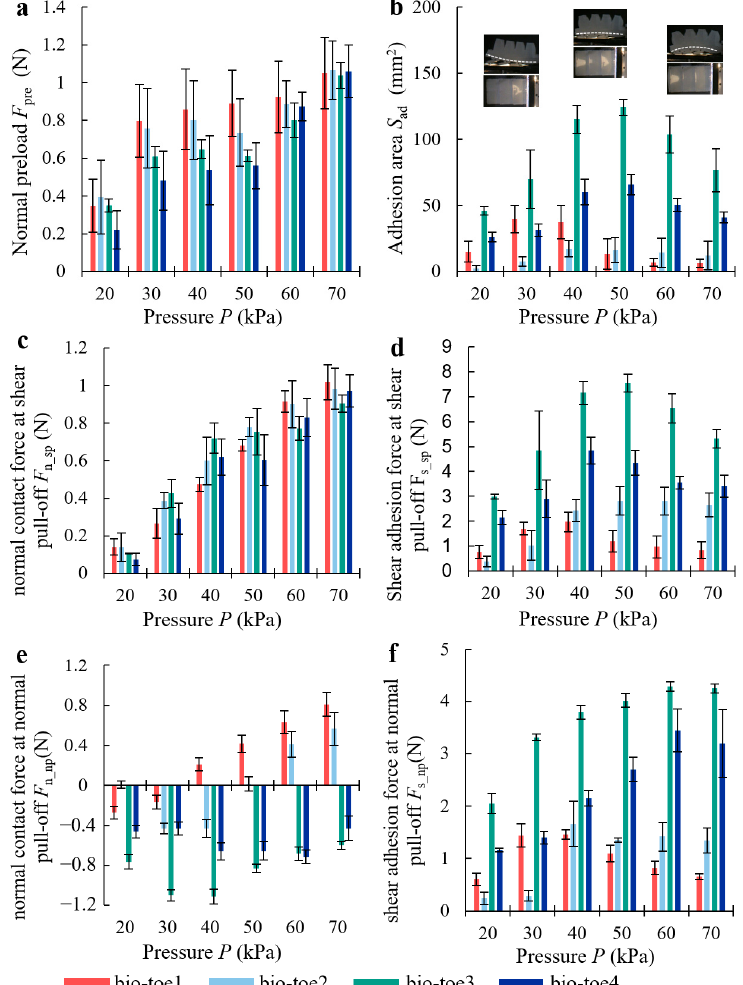
Figure 8. ( a ) Normal preload F pre and ( b ) adhesion contact area S ad of the four bio-toes during the adhesion performance tests. ( c ) Normal adhesion force F n_sp and ( d ) shear adhesion force F s_sp of the four bio-toes during the adhesion performance test of shear pull-off. ( e ) Normal adhesion force F n_np and ( f ) shear adhesion force F s_np of the four bio-toes during the adhesion performance test of normal